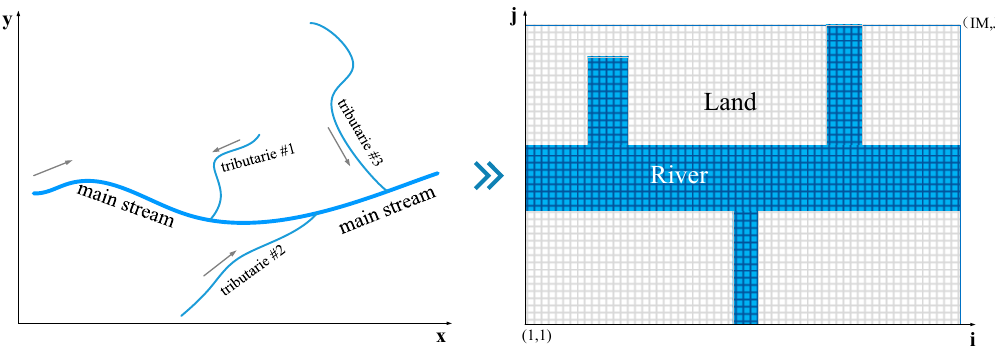
Figure 2. Two dimensional regular grids in river networks. (Grids in grey color are dry grids in the land, grids in blue color are wet grids in rivers).